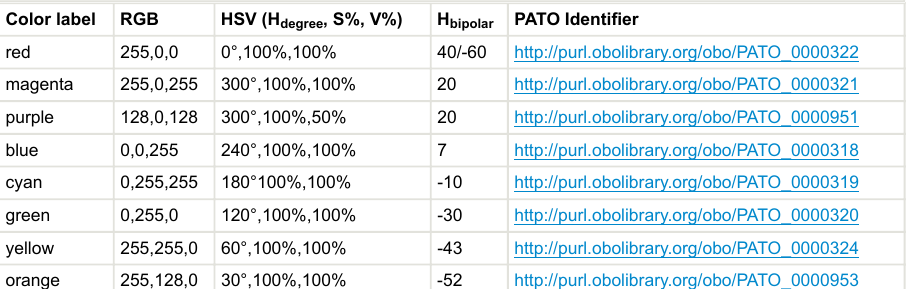
Values for the principle colors of interest as represented in RGB, HSV, H color models and PATO URI.